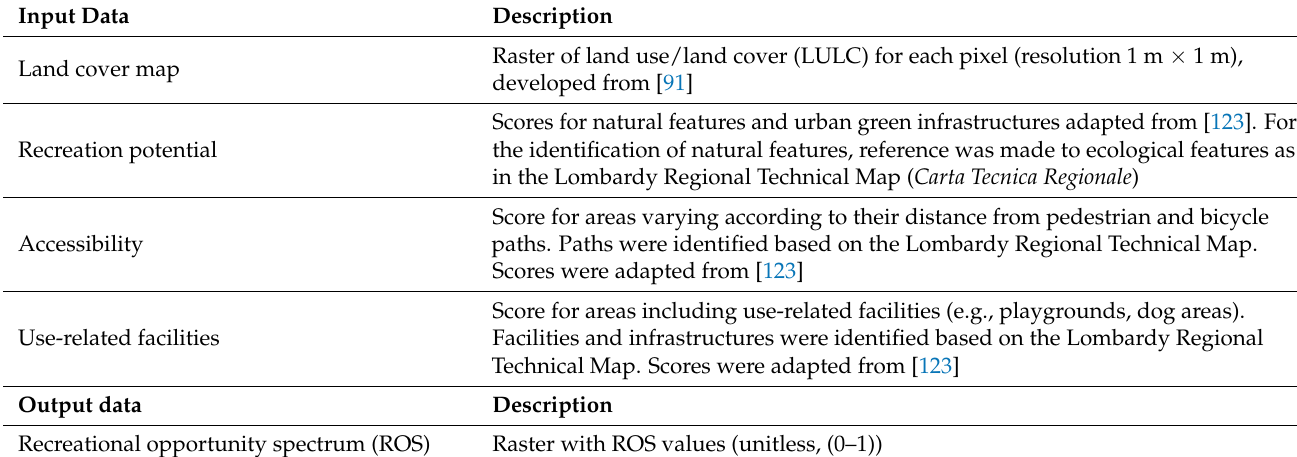
Figure 3. Flow-chart of methodological steps for the assessment of recreation. Adapted from [89,123]. Table 11 reports input and output data for the recreation model. Table 11. Input and output data for the assessment and evaluation of